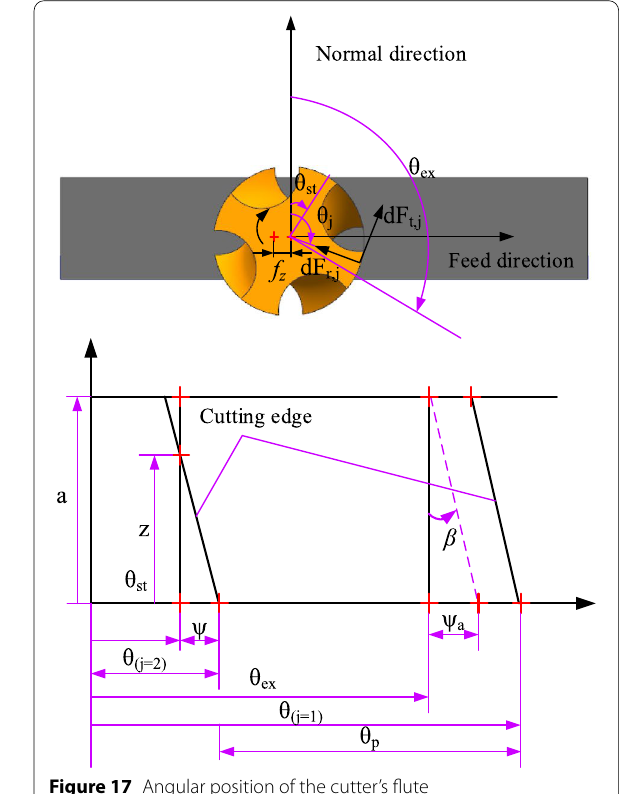
Figure 17 Angular position of the cutter’s